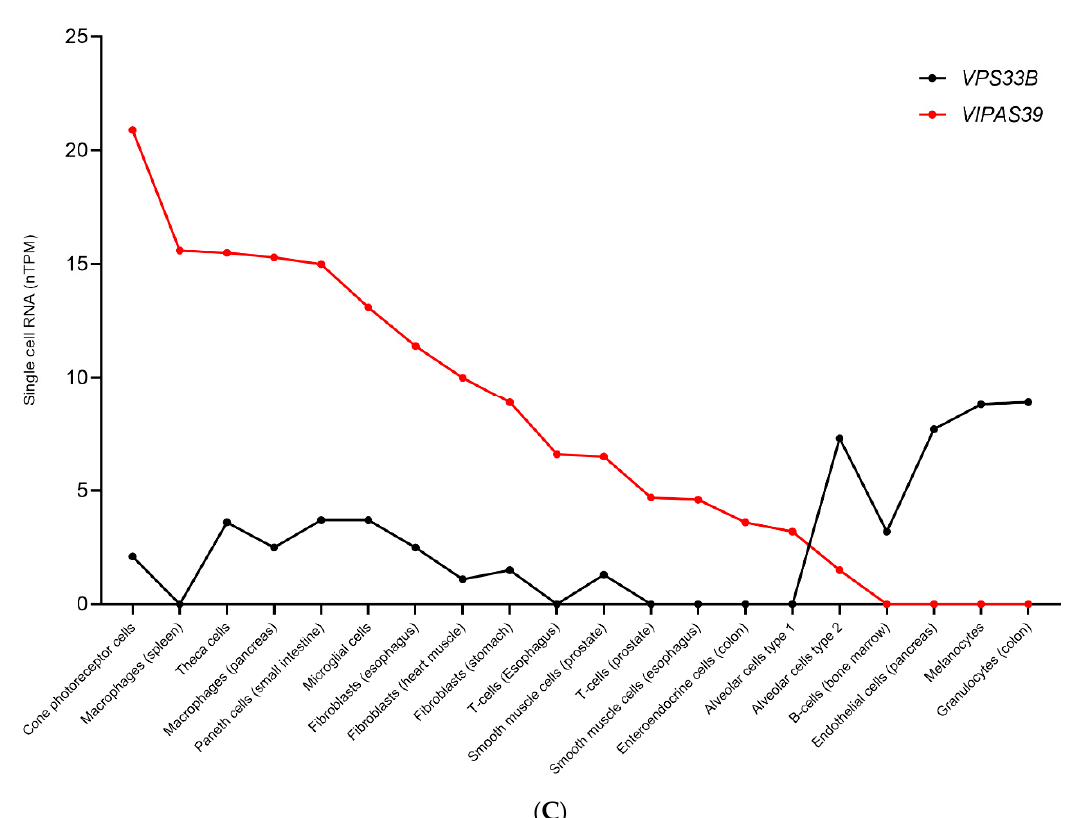
Figure 7. Single cell RNA expression of VPS33B and VIPAS39 in different cell types. RNA levels for each gene are measured in normalised transcripts per million (nTPM) based on RNA-seq data from the Human Protein Atlas (https://www.proteinatlas.org/ accessed on 18 July 2022). ( A ). 1–2-nTPM fold-change between VPS33B and VIPAS39 (1 < fold change < 2). ( B ). 2–4-nTPM fold-change between VPS33B and VIPAS39 (2 ≤ fold change ≤ 4). ( C ). Greater than 5- nTPM fold-change between VPS33B and VIPAS39 (fold change ≥ 5).